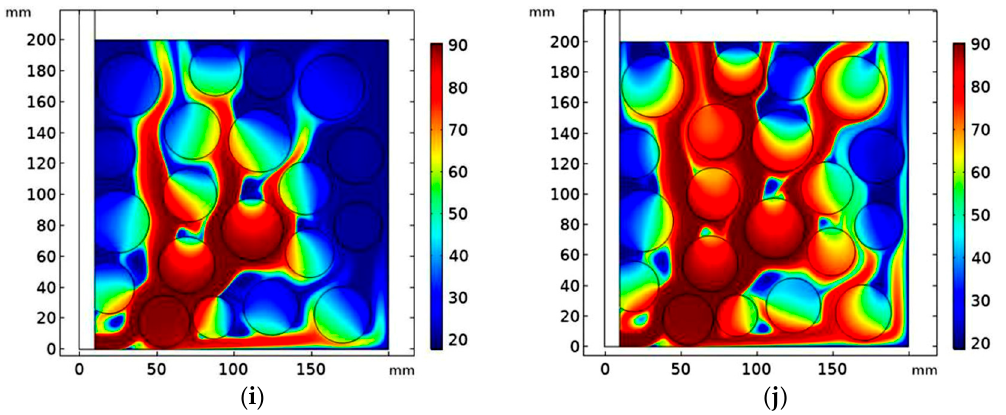
Figure 5. Soil temperature simulation results: ( a ) <2 mm, t=300s; ( b )<2 mm, t=460s; ( c ) 2–7 mm model; ( d )2–7 mm meshing; ( e ) 7–17 mm model; ( f ) 7–17 mm meshing; ( g ) 17–27 mm model; ( h ) 17–27 mm